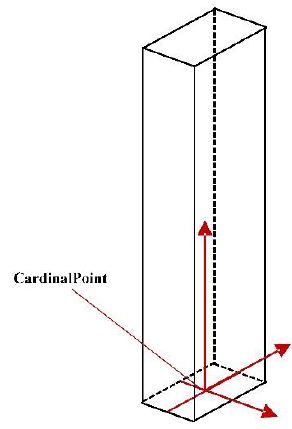
Figure 9. Cardinal point in column element.